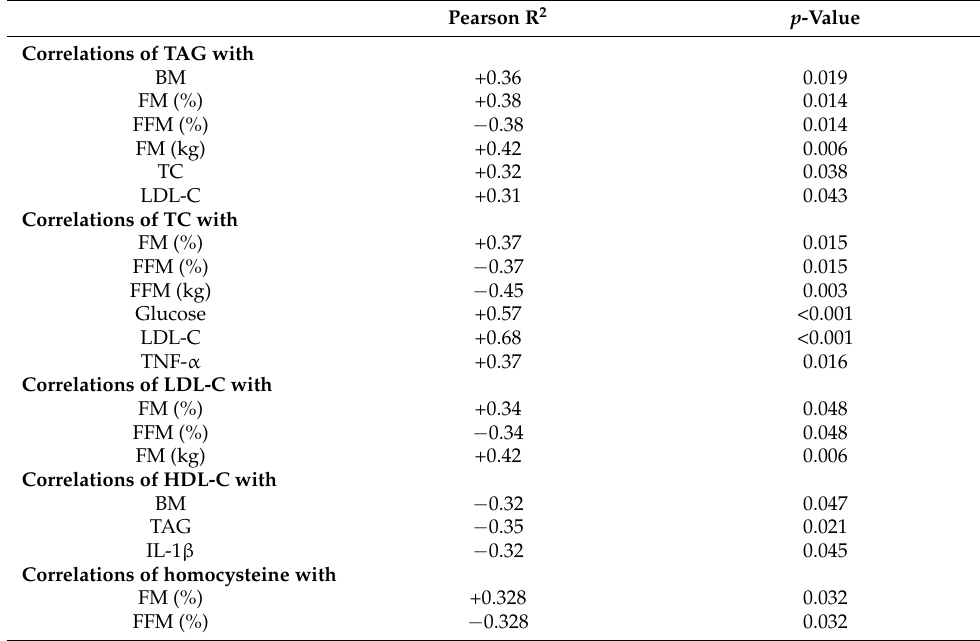
Table 3. Correlations between baseline characteristics.